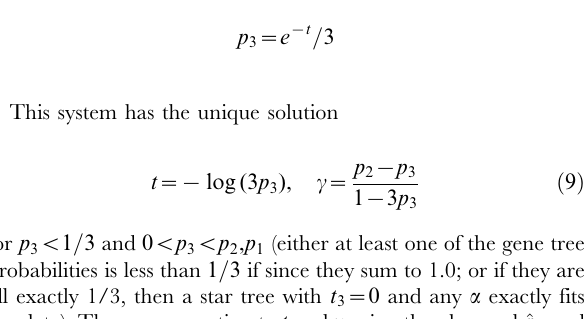
Species phylogeny Figure 3A Figure 3B Figure 3C Figure 3D Figure 3E Figure